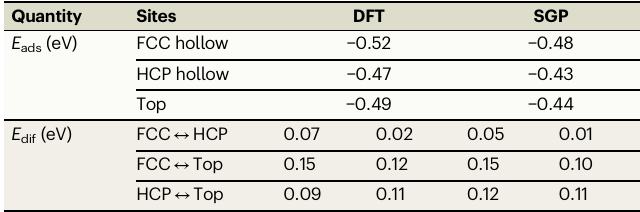
Table 3 | H adsorption energies ( E ads ) and diffusion barriers ( E dif ) on Pt(111), compared with DFT and the SGP model